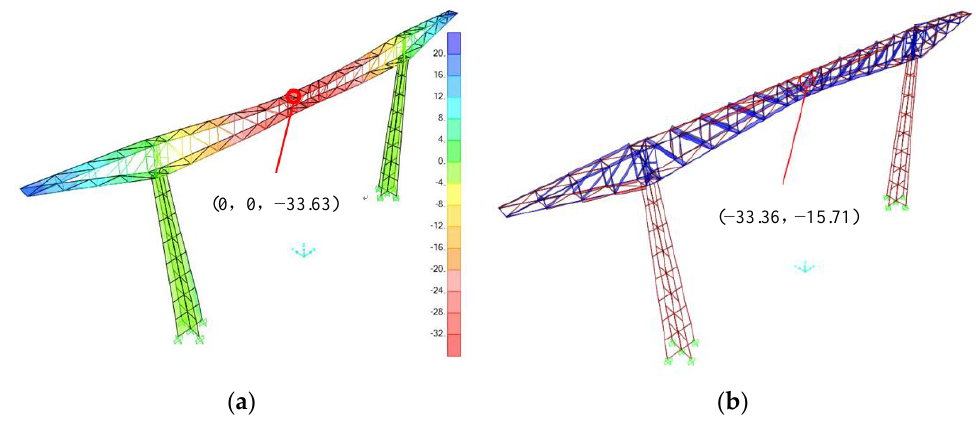
Figure 4. Condition 1. ( a ) Deformation pattern. ( b ) Stress diagram.